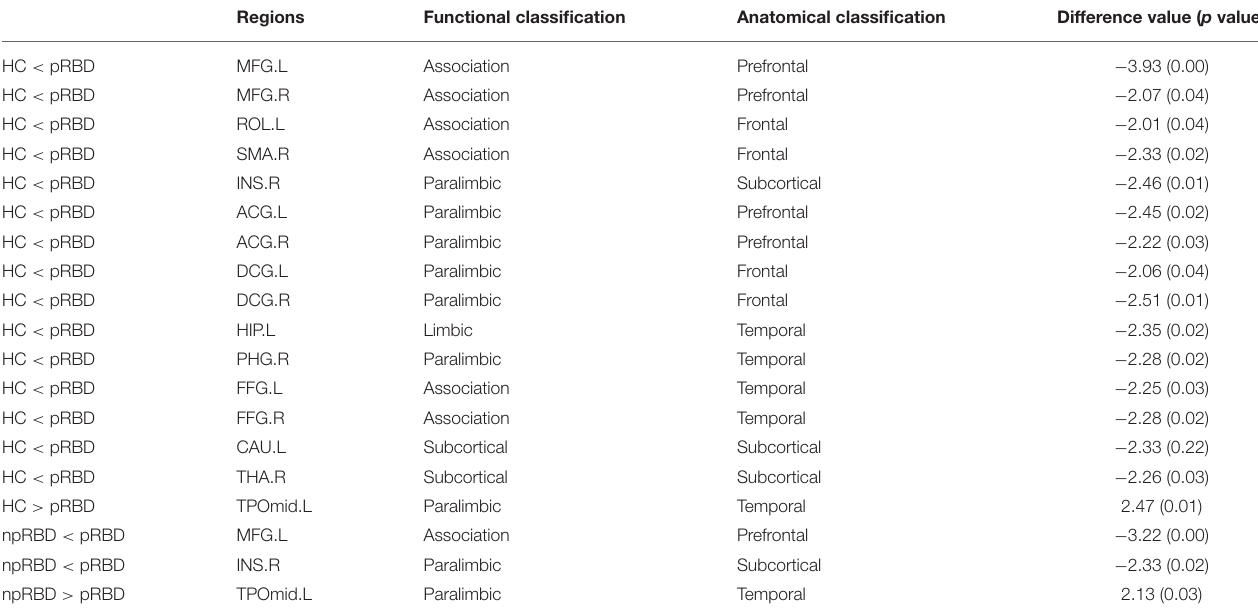
The abbreviations of the 90 brain regions are given in supplementary materials (Online Resource).